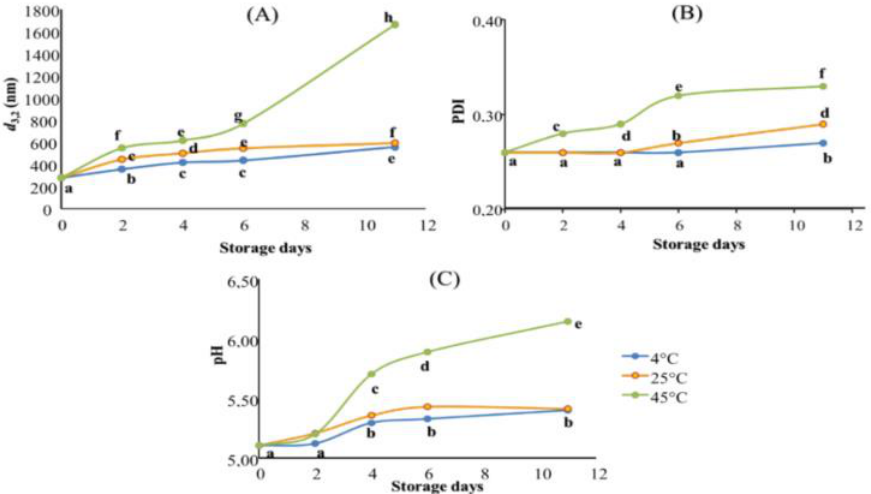
Figure 3. Stability assessment of TNE stored for 11 days at three different temperatures (4, 25 and 45 °C). Results are expressed in terms of ( A ): droplet size measurement (nm); ( B ): PDI values, and ( C ): pH values. Data presented as mean of three repetitions. Values followed by different letters mean statistically significant differences ( p <